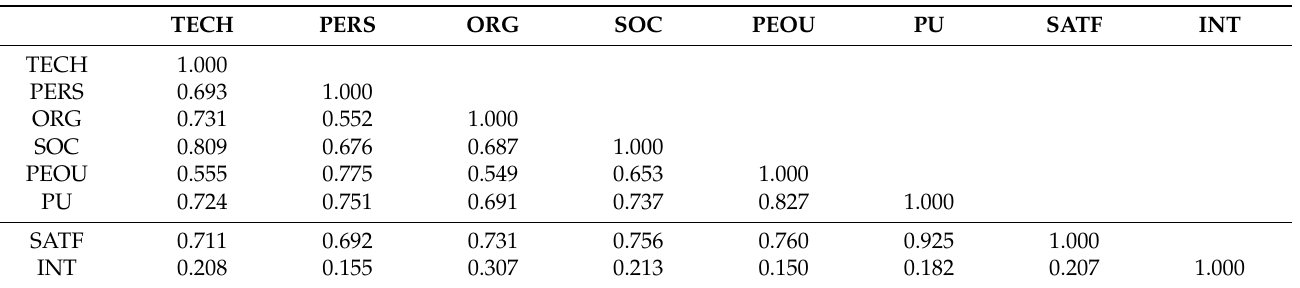
Table 6. Correlation matrix between hypotheses.